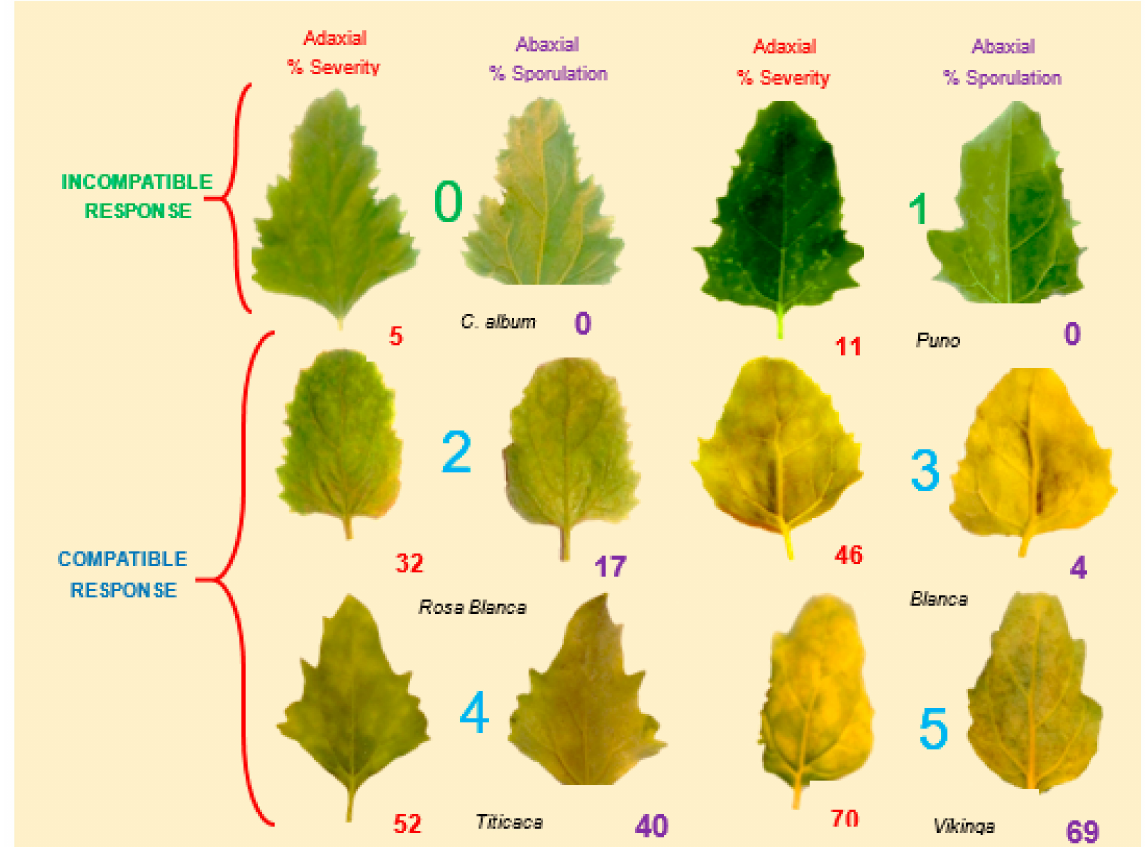
Figure 6. Set of reference cultivars postulated for profiling the virulence of Peronospora variabilis, including C. album and two Bolivian cultivars with intermediate reactions. Leaves from three-week-old artificially inoculated plants. Numbers in red indicate the percentage of severity on the adaxial side, and those in purple indicate the percentage of sporulation on the abaxial side [52]. Numbers in green (incompatible response) and blue (compatible response) correspond to Ochoa’s scale: 0 = no symptoms; 1 = 2 − 5-mm lesion with truncated mycelium in the mesophyll of the leaf; 2 = 4 − 8-mm chlorotic lesions with minor sporulation; 3 = medium-sized and confined chlorotic lesions with sporulation mainly on the abaxial side of the leaf; 4 = large, not clearly confined chlorotic lesions with sporulation mainly on the abaxial side of the leaf; 5 = mild chlorosis with abundant sporulation on both adaxial and abaxial sides of the leaf (Ochoa et al., 1999 [40], Colque-Little et al., 2021 [52]). Both assessments are comparable in terms of severity and sporulation; thus, the existence of resistance factors is hypothesized in this set of reference